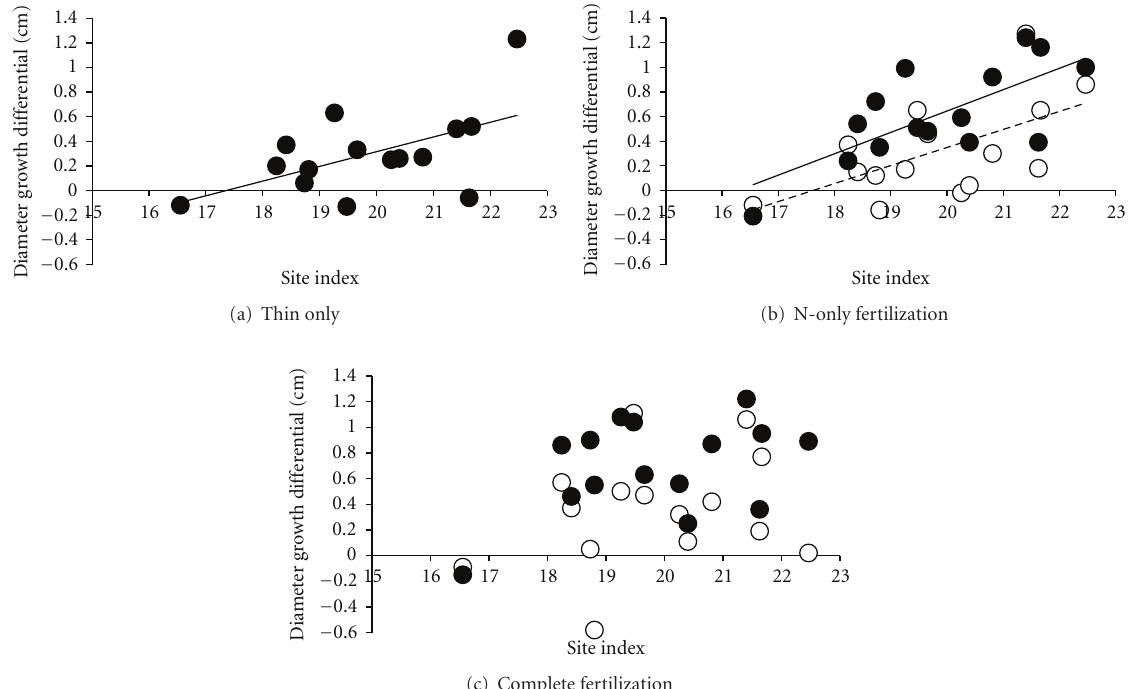
Figure 5: Diameter growth di ff erential of thinning and fertilization treatments relative to site index of the control stands. The response variable, diameter growth di ff erential, is the di ff erence between DBH growth after three years of the treated stand and DBH growth of the associated control stand. White dots represent unthinned plots and black dots represent thinned plots. (a) Thin only, P = 0 . 032, r 2 = 0 . 254, (b) N-only, P = 0 . 020, r 2 = 0 . 303, N-only + thinning, P = 0 . 003, r 2 = 0 . 469, and (c) complete fertilization, P = 0 . 334, complete + thinning, P = 0 .